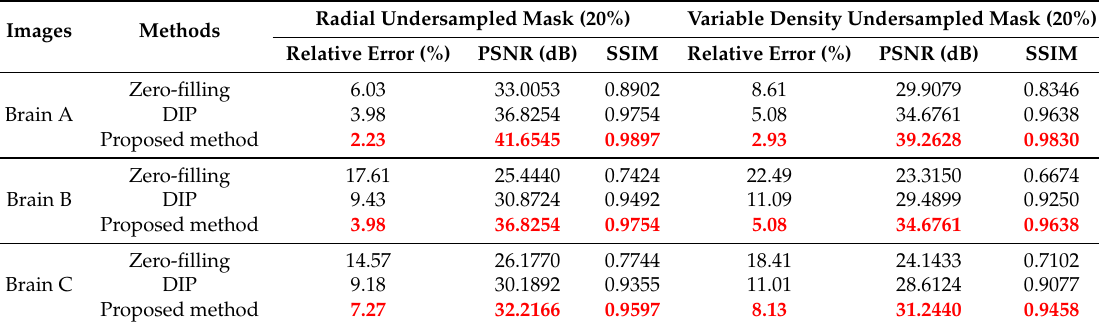
Table 4. Relative errors, PSNR, and SSIM values of reconstruction by different methods at 20% sampling rates under the radial undersampled mask and variable density undersampled